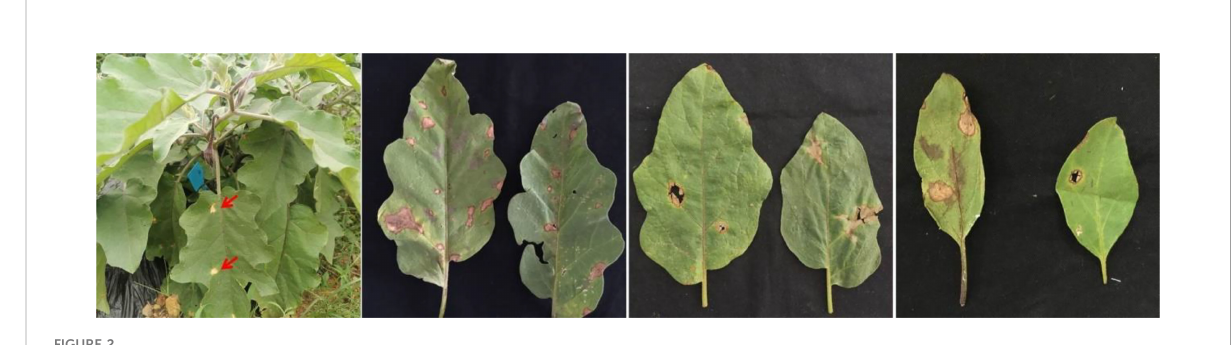
FIGURE 2 Field symptoms of leaf blight of P. vexans